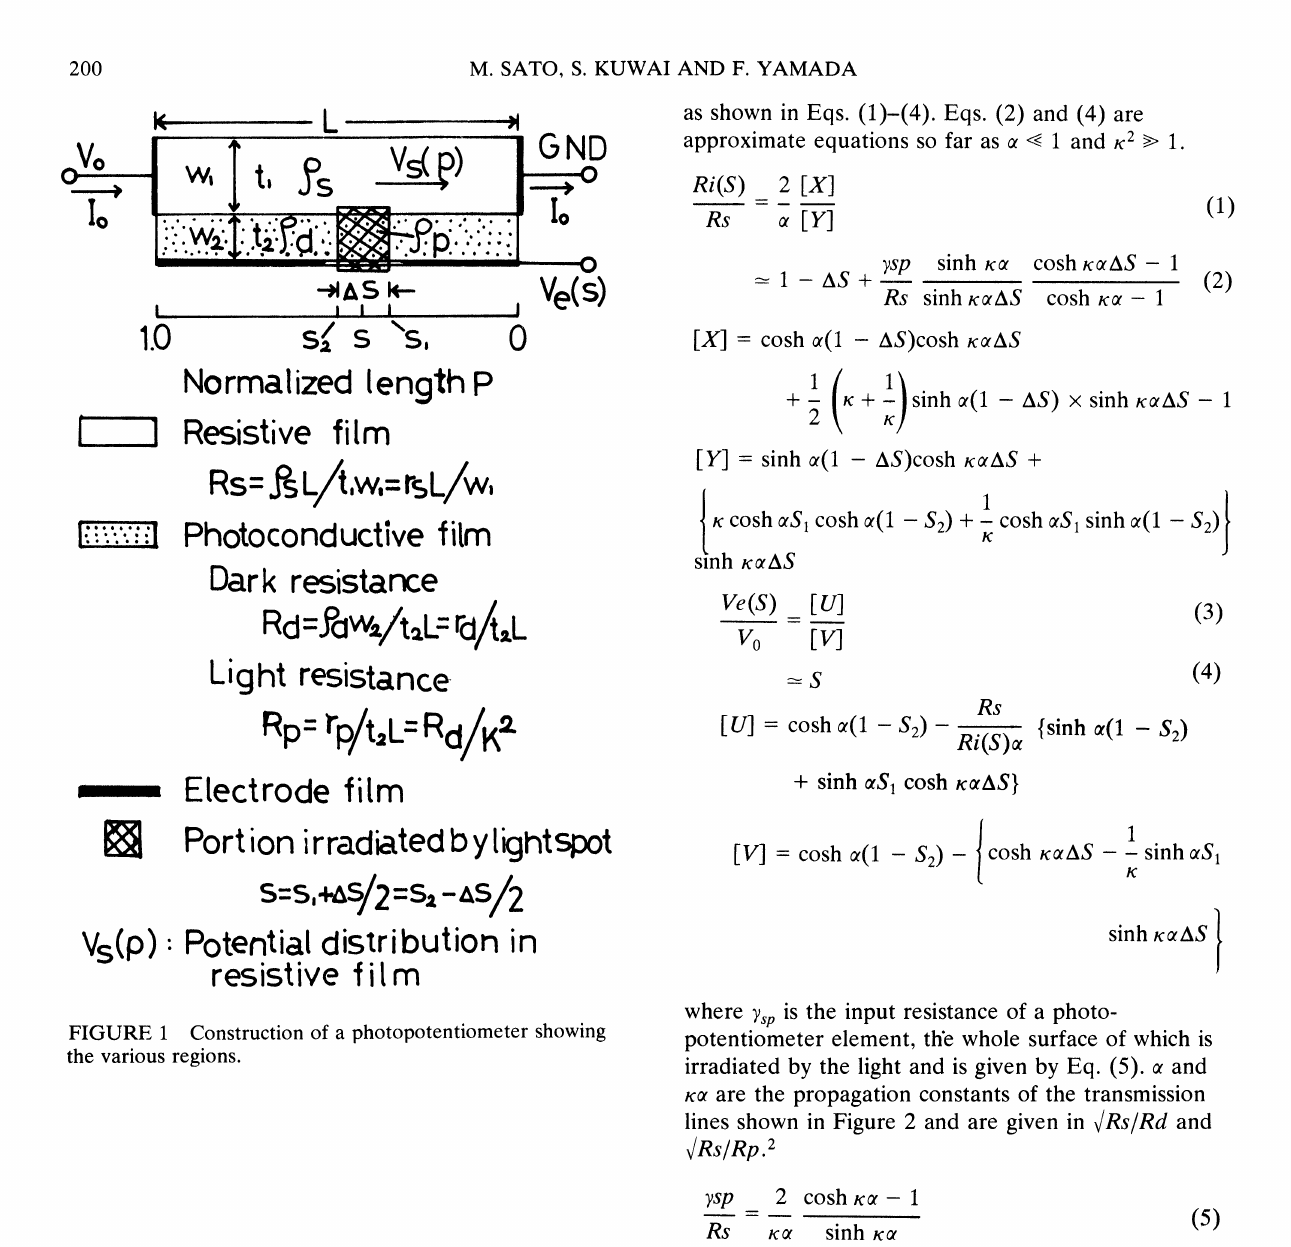
The dependence of value 0 on the voltage distribution Vs(P) in the resistive film is shown in Figure 3. Vs(P) is not a straight line because of degradation by dark resistance Rd. Rd/Rs <= 400 is necessary to obtain a linearity of less than 0.1% on voltage distribution Vs(P). The output voltage change is shown in Figure 4 when AS is fixed and Rd/Rp(x 2) is changed. One feature is that output voltage varies according to the value of Rd/Rp. Rd/Rp >- 5000 is necessary to obtain an output voltage of more than